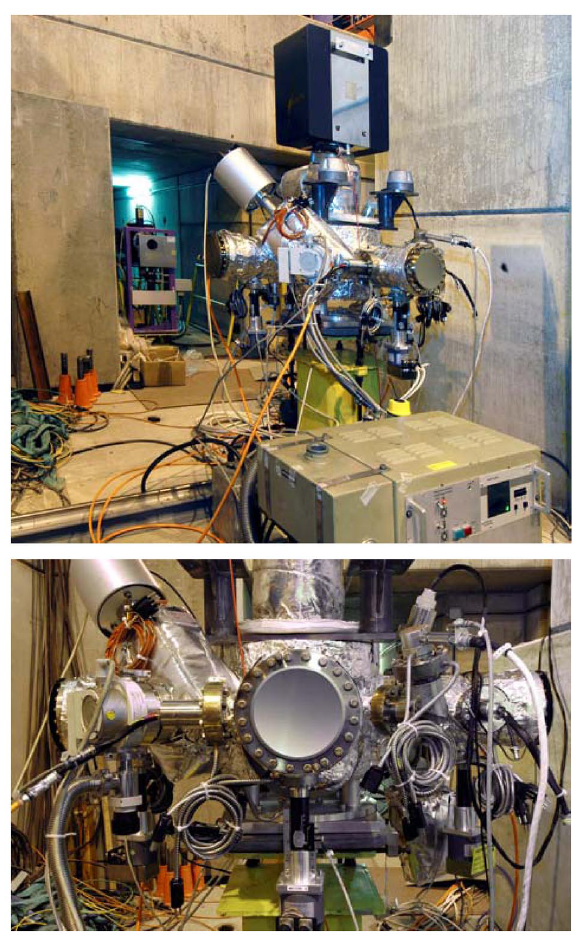
FIG. 3. (Color) Ion-induced desorption experiment installed on 31 October 2003 in the T4-H8 beam line at the CERN SPS (upper photo). Close view of one collimator chamber with the stainless steel window in the center, as seen by the ion beam, the collimator motorization at the bottom, and the electron detector on the left side (lower